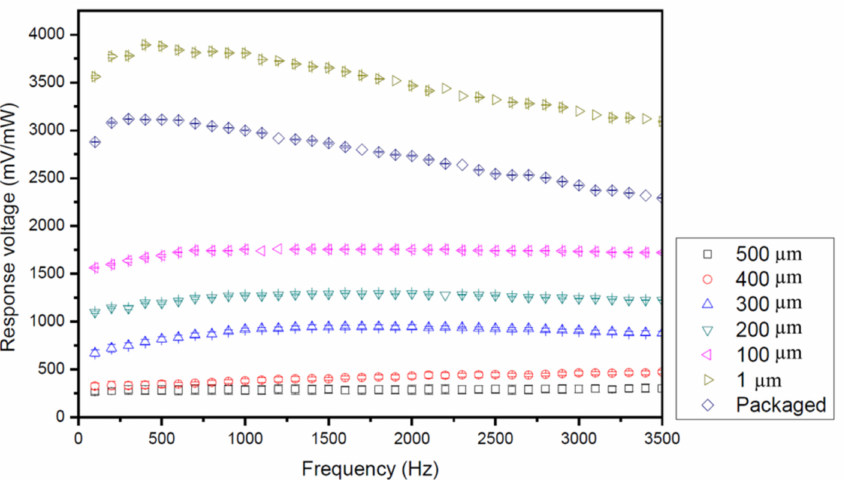
Figure 10. Voltage responsivity of sensors with substrate thicknesses of 1, 100, 200, 300, 400 and 500 µ m and cutoff frequencies in the range of 0–3500 Hz.